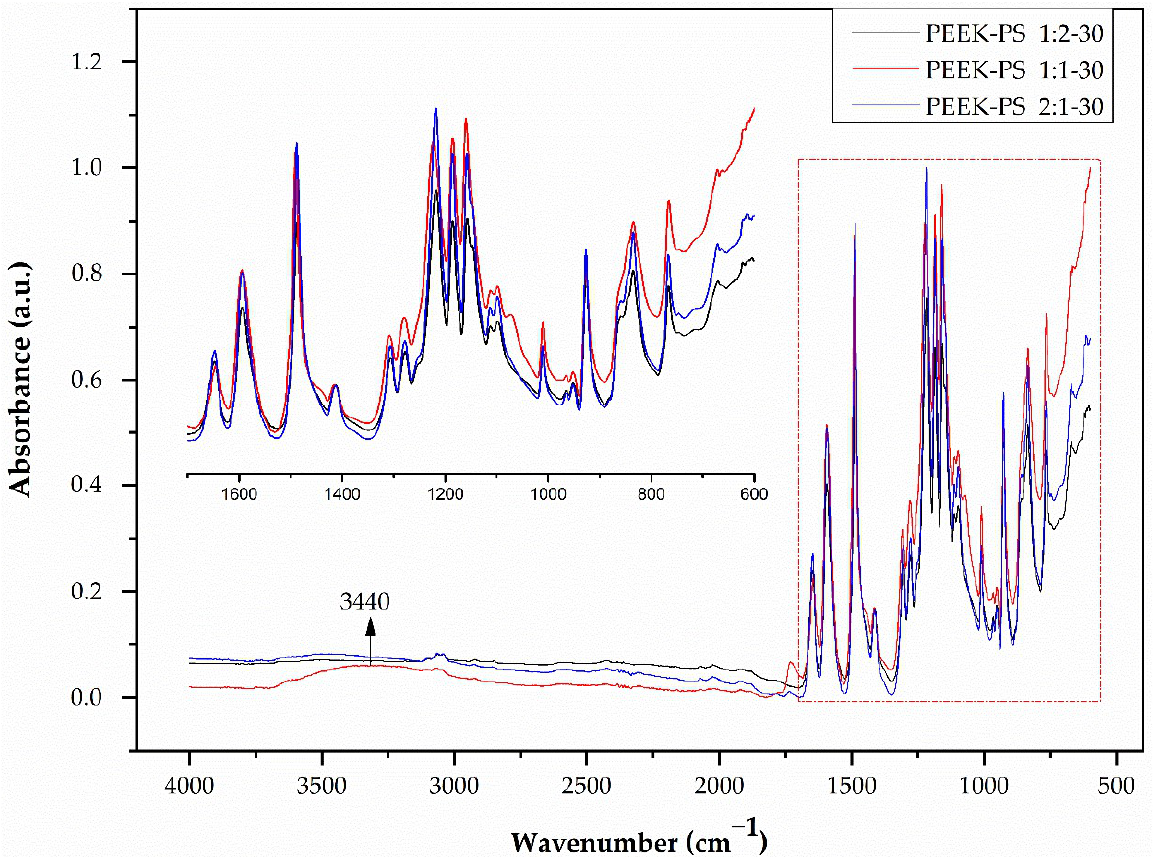
Figure 3. PEEK-PS FTIR spectra at concentrations of 1:2, 1:1, and 2:1 with 30 s of immersion in the piranha solution.